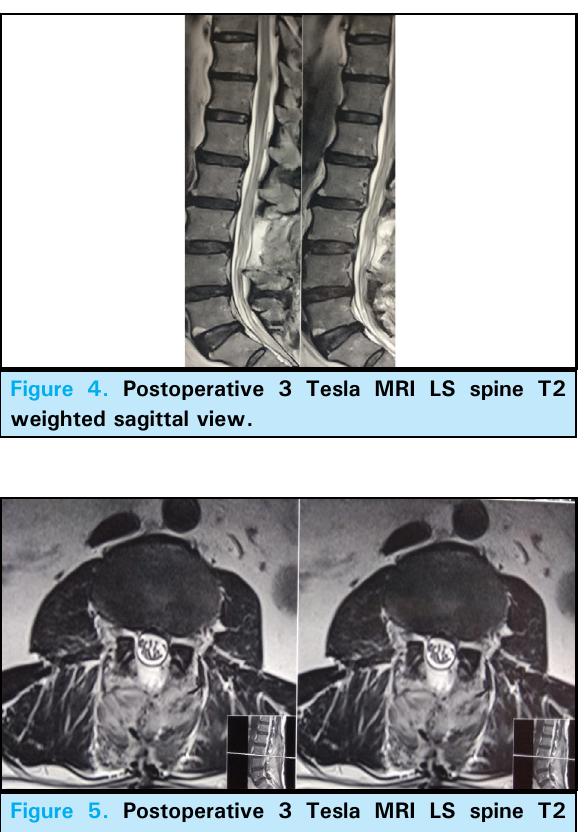
Figure 5. Postoperative 3 Tesla MRI LS spine T2 weighted axial section at the L3-L4